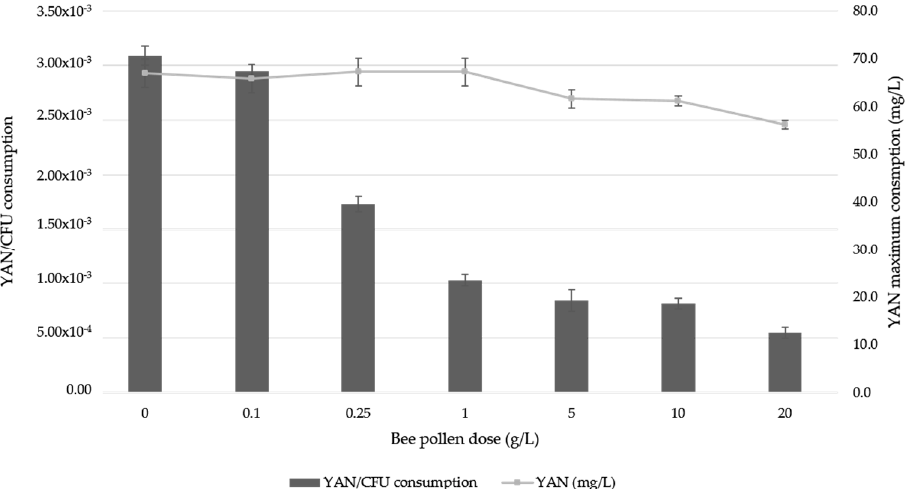
Figure 3. Maximum consumption of yeast assimilable nitrogen (YAN) per colony forming unit (CFU) during the exponential growth phase of Palomino Fino wine with different bee pollen doses and control.